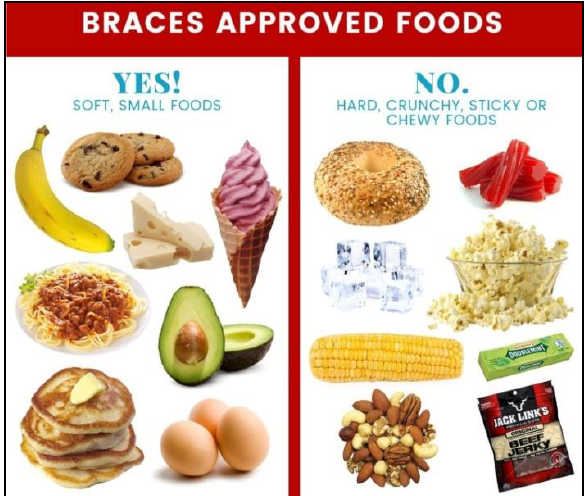
Figure 1: Allowed and not allowed foods in the course of fixed orthodontic therapy